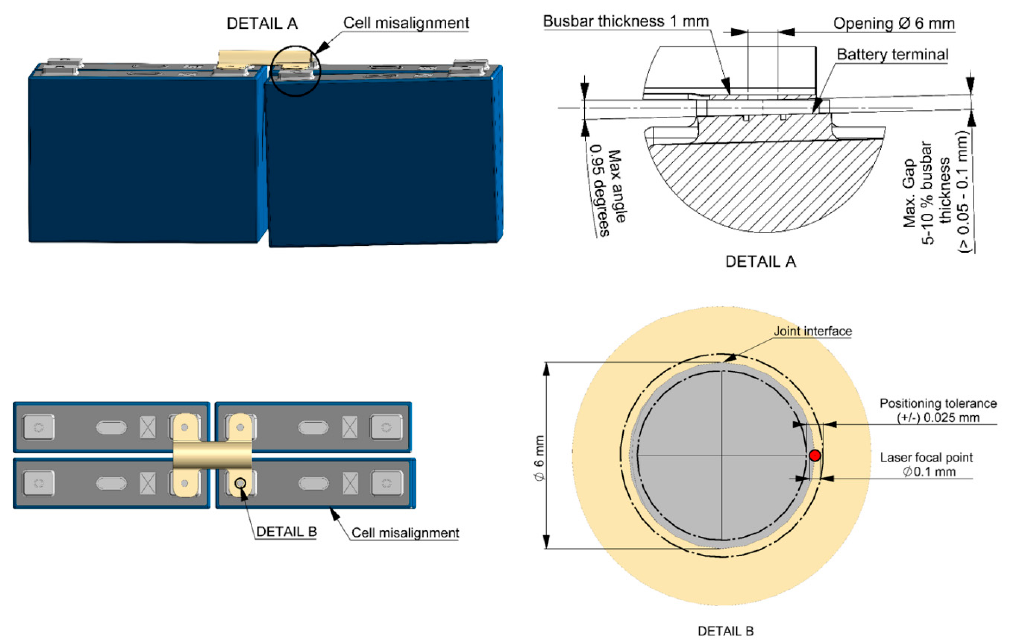
Figure 6. Positioning accuracy tolerances in battery tap welding with 0.1 mm diameter of laser focal point and 1.0 mm busbar thickness.